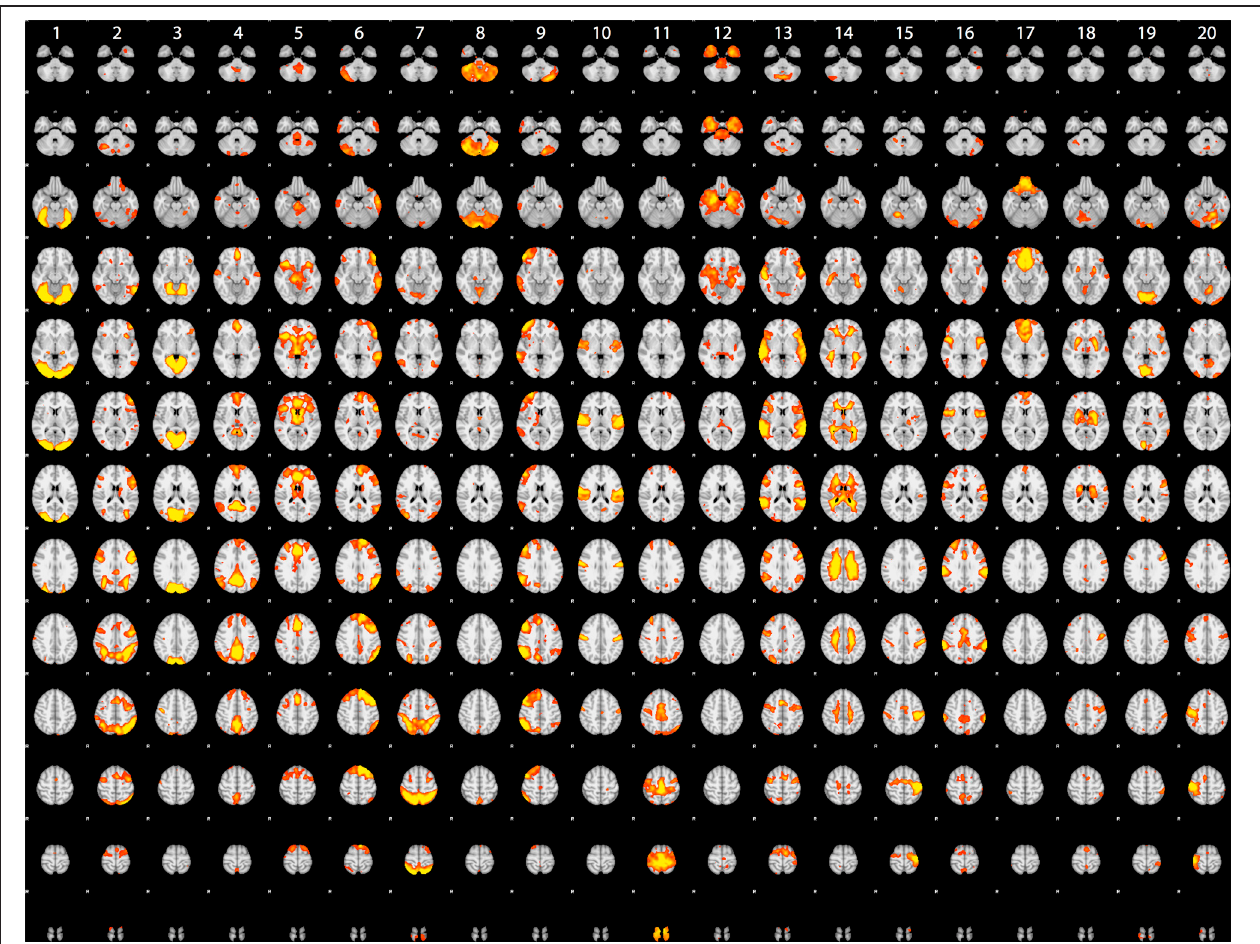
FIGURE 2 | Rendered maps of the voxels with significant loadings on the 20 ICA components identified statistical images for the datasets listed in Table 1. Each column displays the loading for a single component; voxels shown in red had positive loading for that